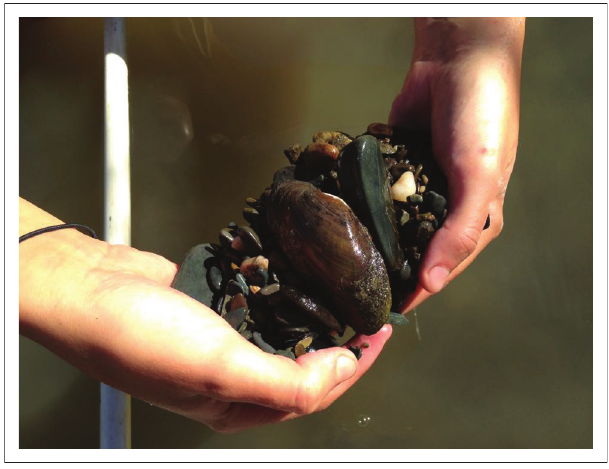
FIGURE 6: Live adult specimen of Unio caffer collected from sediments of the Oorlogskloof River, 19 April 2017, Oorlogskloof Nature Reserve in the Northern Cape, South